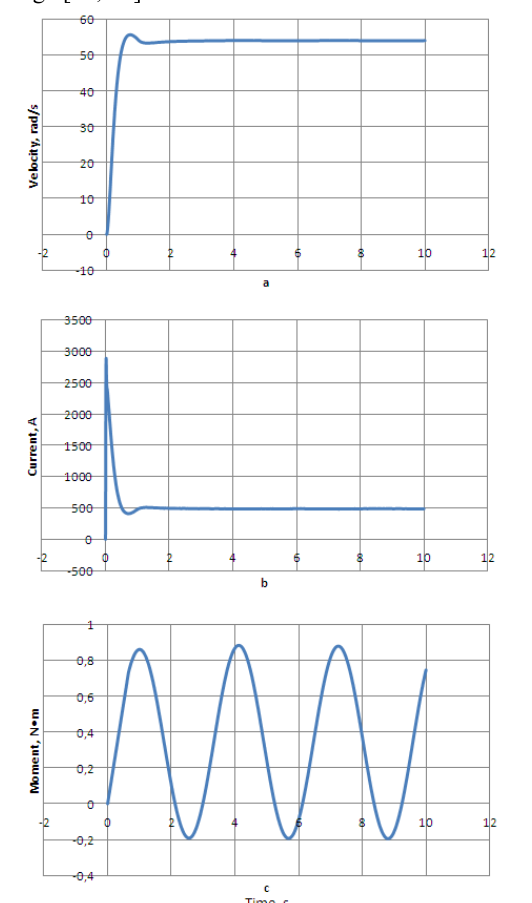
Figure 7. Results of modeling for a completely filled